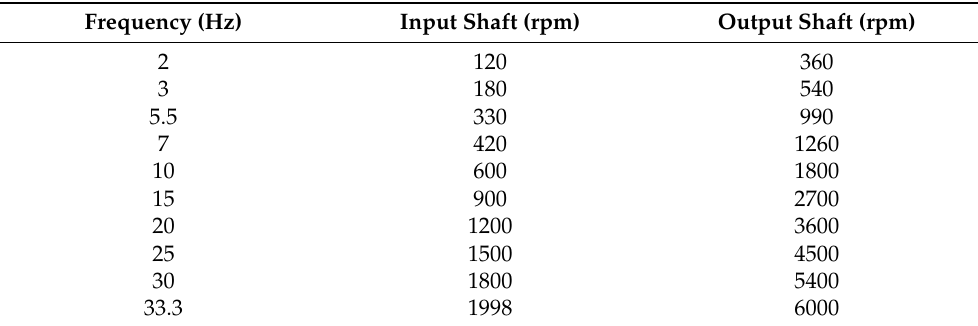
Table 3. Rotational speeds for testing of frequency, input shaft and output shaft.